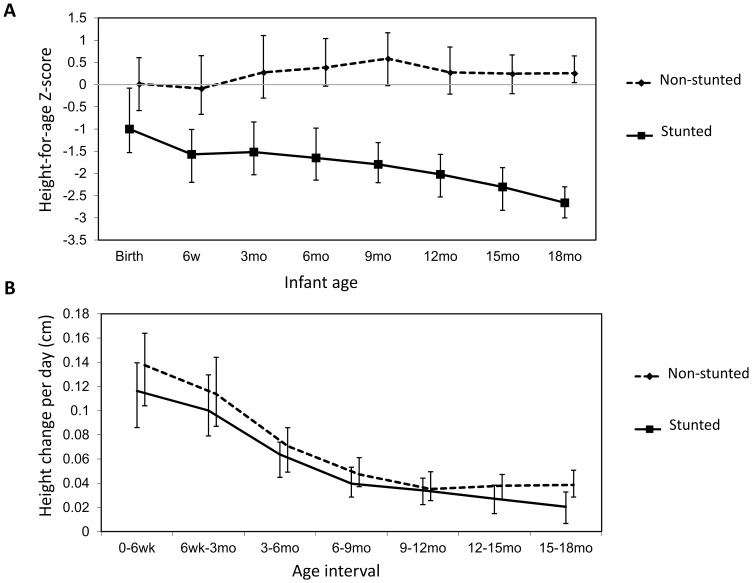
Growth in cases and controls.A: Median height-for-age Z-score (HAZ) in non-stunted (dashed line) and stunted (solid line) infants between birth and 18 months of age, with interquartile range. B: Median growth velocity in non-stunted (dashed line) and stunted (solid line) infants between birth and 18 months of age, with interquartile range. Growth velocity was calculated as height change per day, by comparing height (in centimeters) at consecutive visits and dividing by the number of days between visits.